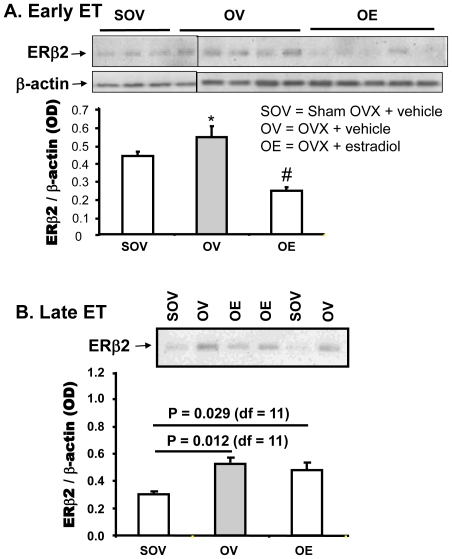
Persistent loss of ovarian hormones diminishes the effects of estradiol on the regulation of ERβ2 expression.ERβ2 protein expression was evaluated by Western blot in hippocampus of rats OVX at 9 months of age in which E2 treatment was started 6 days (A, Early ET) or 180 days (B, Late ET) after OVX. Data is presented as average ± SEM of optical density normalized with optical density of β-actin (n = 8 in SOV, 8 in OV and 9 in OE. * = p<0.05 vs. sham OVX; # = p<0.01 vs. sham OVX.